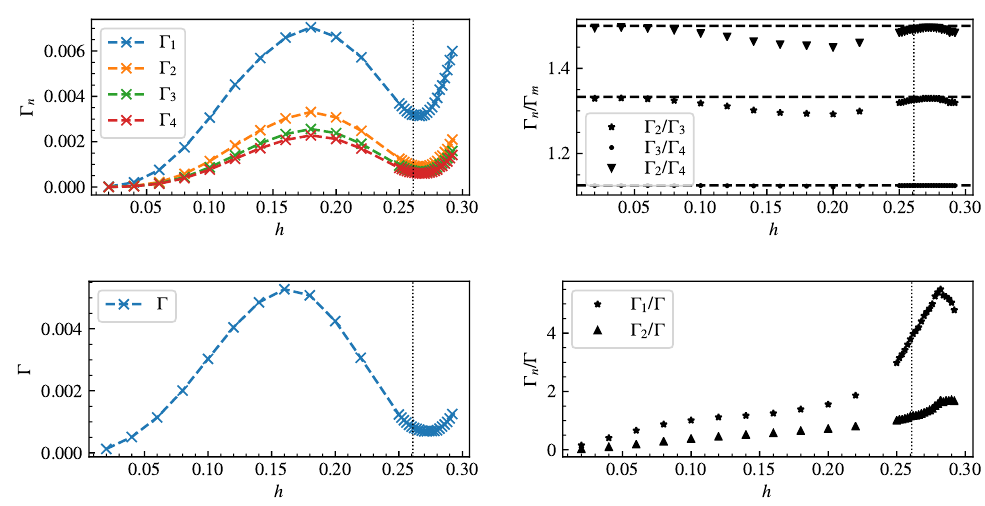
Figure 4.1: Left panels: Entropy growth rates Γ (top) and magnetisation relaxation n rate Γ (bottom) in units J = 1 for longitudinal quenches in the quantum Ising spin chain starting from g = 1.75 as a function of the longitudinal coupling. Right: Ratios Γ / Γ / Γ (bottom). The dashed lines represent the universal ratios (4.4) (top) and Γ n m n that are restored in the limit h → 0. The vertical line is drawn at the value h where crit the second quasi-particle appears in the post-quench